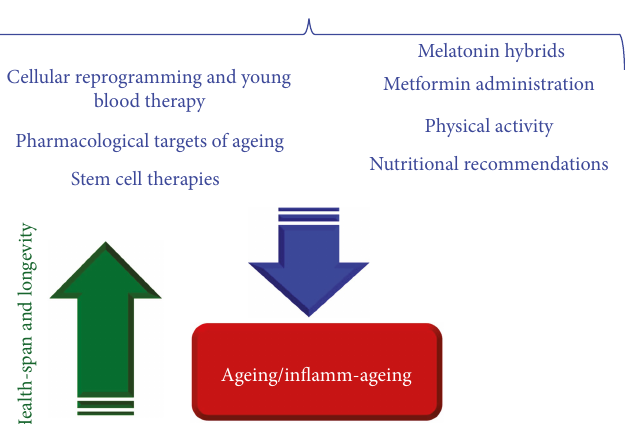
Figure 3: Anti-in fl amm-ageing and anti-age-related disease treatments: described and discussed. They seem to have bene fi cial e ff ects regarding the ageing/in fl amm-ageing processes and reciprocally improving health-span and